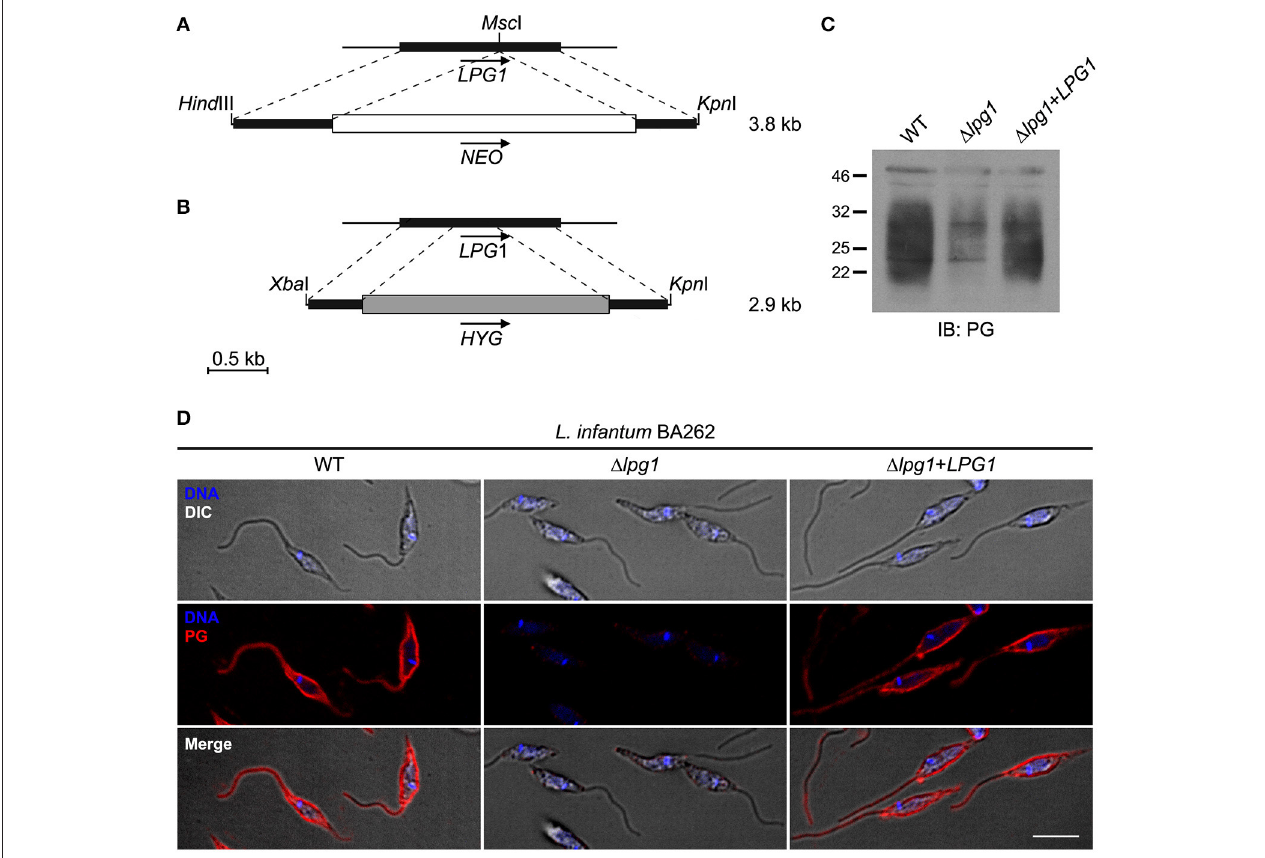
FIGURE 1 | Constructs for the targeted deletion and complementation of the LPG1 gene in Leishmania infantum . (A,B) LPG1 :: NEO and LPG1 :: HYG targeting constructs for the disruption of LPG1 . For the LPG1 :: NEO construct, the NEO resistance cassette (white box) was inserted in the Msc I site of the LPG1 ORF (black rectangle). In the LPG1 :: HYG construct, portions of the LPG1 ORF (black rectangles) corresponding to positions + 1 to + 437 and to positions + 781 to + 1247 downstream of the ATG translation initiation codon flank the HYG resistance cassette (shaded rectangle). Dashed lines delimit regions of recombination between the LPG1 gene and the targeting constructs. Arrows indicate gene orientation. (C) Western blot analysis of LPG expression in WT, 1 lpg1 , and 1 lpg1 + LPG1 promastigotes. Parasite lysates were probed with the anti-phosphoglycan (PG) antibody CA7AE, as described in Materials and Methods. (D) Confocal immunofluorescence analysis of WT, 1 lpg1 and 1 lpg1 + LPG1 parasites. Late log-phase promastigotes were adhered on Poly-L-Lysine-coated glass coverslips, fixed and incubated with DAPI to stain DNA (blue), and with the CA7AE antibody to visualize LPG and other Gal( β 1,4)Man( α 1-PO4) repeating unit-containing PGs (red), as described in Materials and Methods. Fluorescence staining images merged with differential interference contrast (DIC) are shown in the lower panels. Scale bar, 5 µ